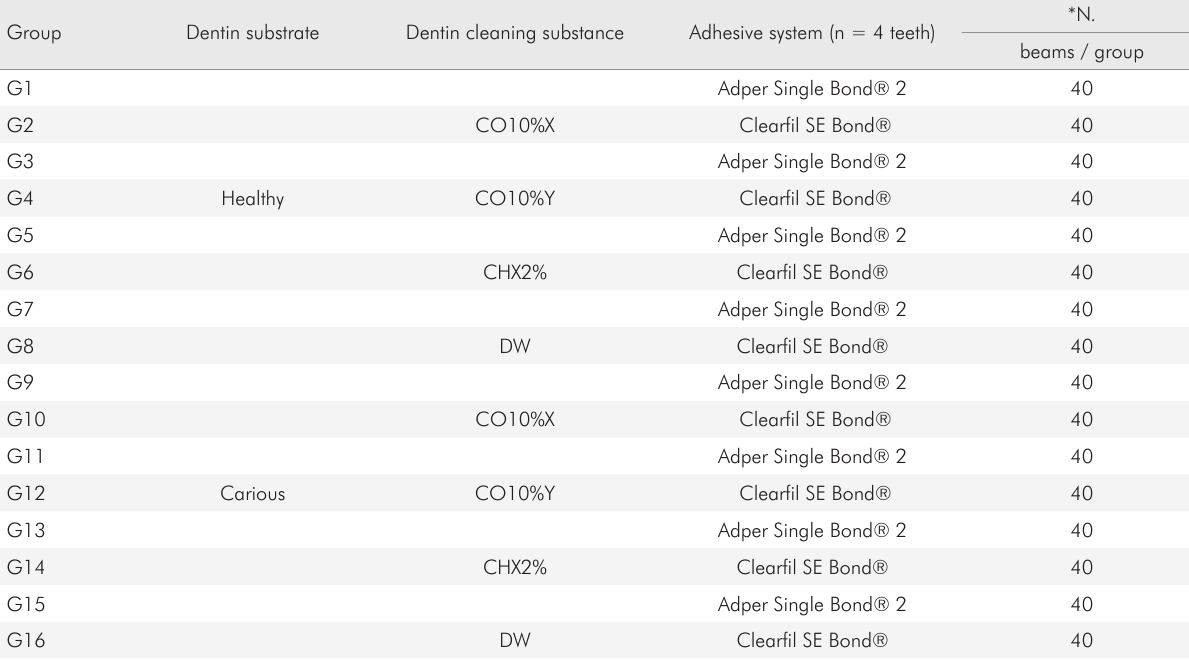
Table 3. Group and sample distribution according to healthy or carious substrate, test substance for dentin cleaning, and adhesive